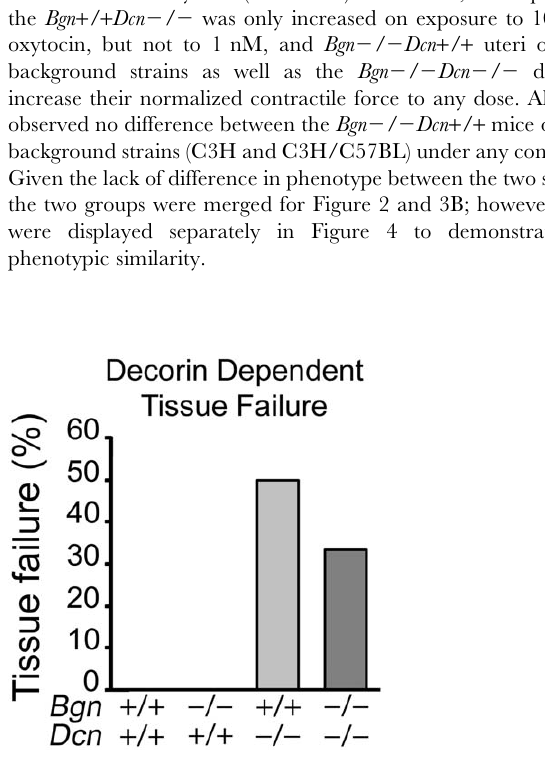
Figure 2. Mice lacking decorin alleles show an increased incidence of tissue failure upon loading to 10 g. P =0.027. Chi- square test. Bgn + / + Dcn + / + n=12; Bgn 2 / 2 Dcn + / + n=17; Bgn + / + Dcn 2 / 2 n=14; Bgn 2 / 2 Dcn 2 / 2 n=6. Bgn =biglycan. Dcn